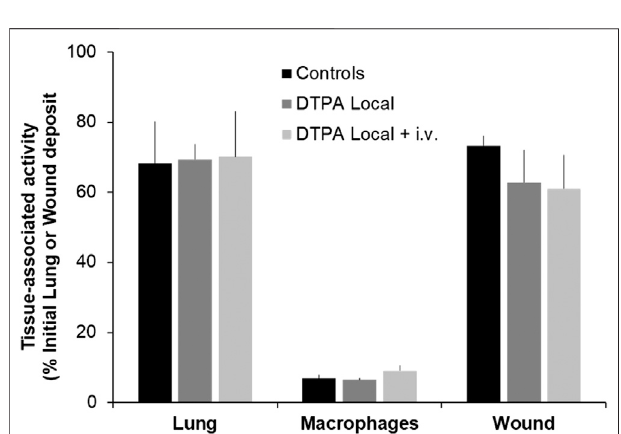
FIGURE 5 | Effect of local DTPA or local DTPA followed by DTPA systemicadministrations onactivity levelsat theprimary siteofcontamination. Animals were contaminated by MOX inhalation (12 kBq) or deposition in a wound (13 kBq) as described, and were euthanized 21 days later. Local administration to lungs (DTPA powder about 5 µmol/kg) or wound (DTPA solution 30 µmol/kg) was started at 2 h ( “ DTPA Local ” ). For combined local and systemic DTPA treatment ( “ DTPA Local + i.v. ” ) animals received the local dose at 2 h then two intravenous DTPA per week from day one to day 20 (30 µmol/kg).Alveolarmacrophageswerepreparedasdescribedandfordata normalization for comparative purposes of DTPA ef fi cacy are expressed as activity per 10 6 macrophages and as afunction of the initial lung deposit. Data are the means ± S.D. of 3 – 6